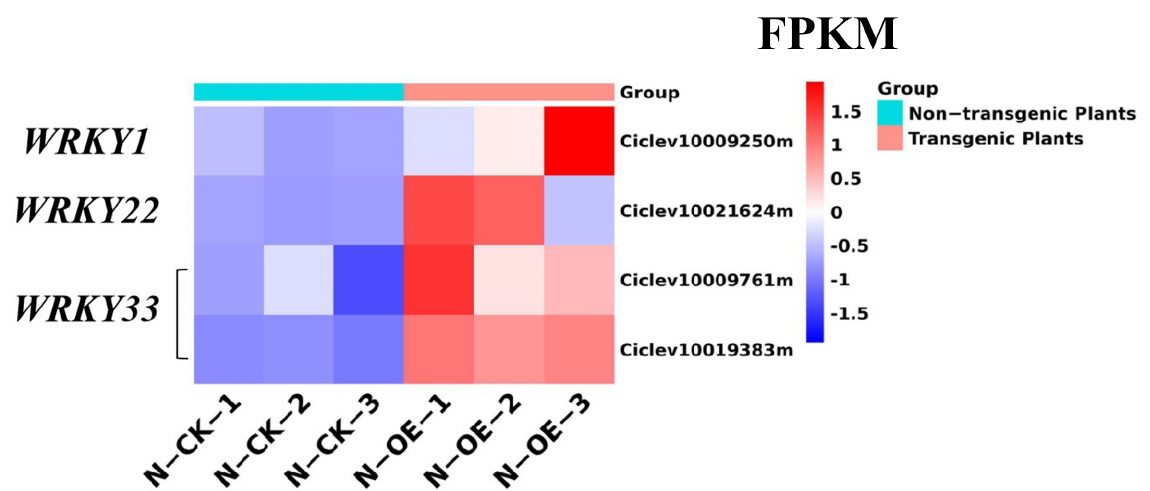
Figure 10. The FPKM of the WRKYs in the non-transgenic plants versus the transgenic